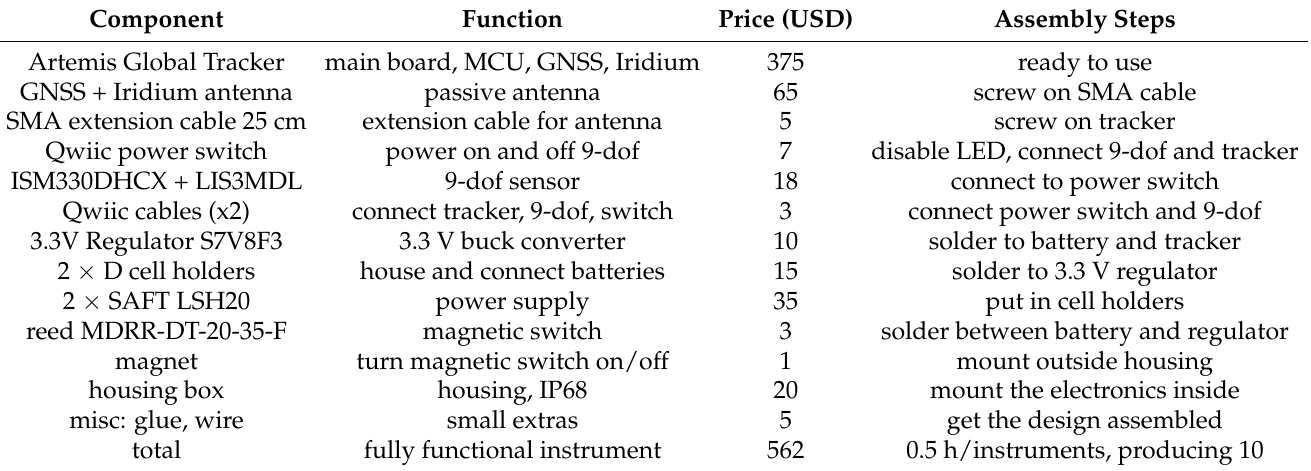
Table 2. A representative list of components needed to build an instrument monitoring drift (GNSS) and wave activity (9-dof sensor). The assembly time for a single instrument, when assembling a series of 10 instruments in bulk, is about 0.5 h once the user is familiar with the design.